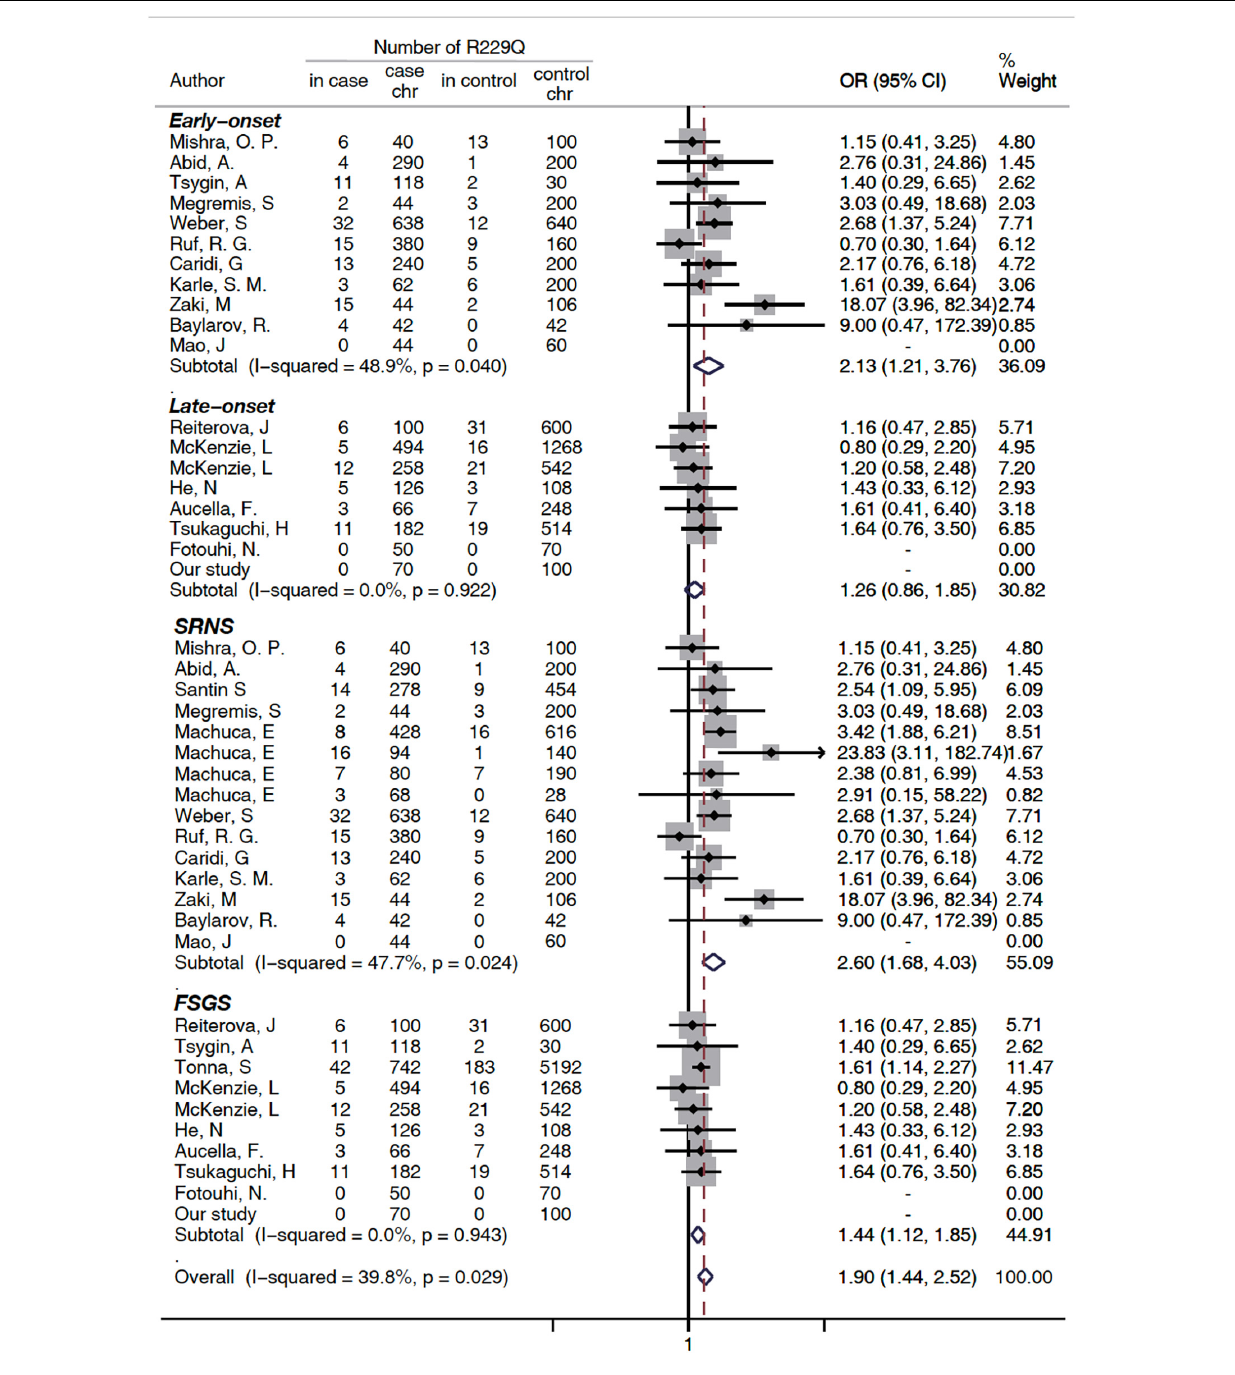
95% CI = 1.25-18.81, P = 0.02), and dominant (OR: 2.09, 95% CI = 1.04-4.21, P = 0.04) models, while no significant association was found in all the three genetic models among the late-onset